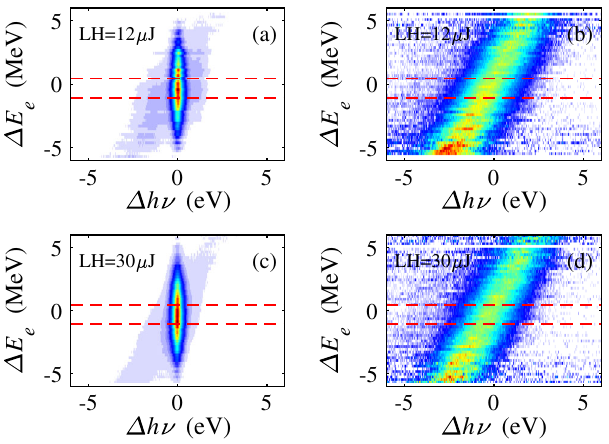
FIG. 11. Average spectral intensity as a function of electron beam energy and photon energy for different operation modes and laser heater (LH) energies at U15. (a): self-seeding and LH 12 μ J. (b): SASE and LH 12 μ J. (c): self-seeding and LH 30 μ J. (d): SASE and LH 30 μ J. The red dashed lines denote the beam energy range used for the mode number analysis